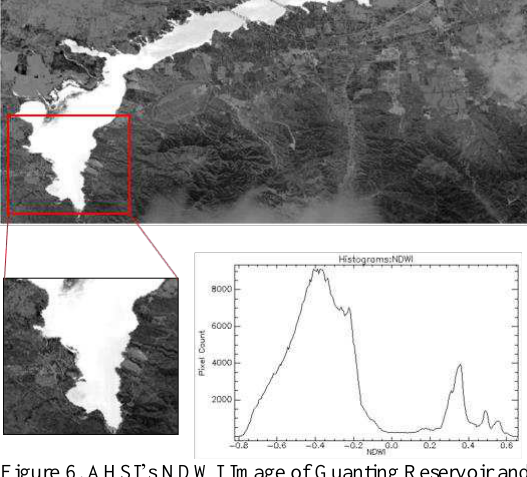
Figure 6. AHSI ’ s NDWI Image of Guanting Reservoir and Corresponding Histogram.